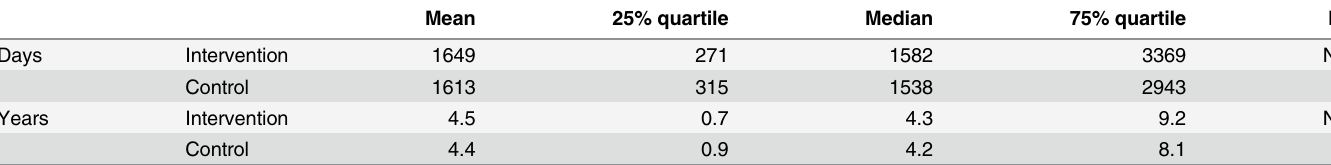
Table 2. Patient Continuous Time in Healthcare